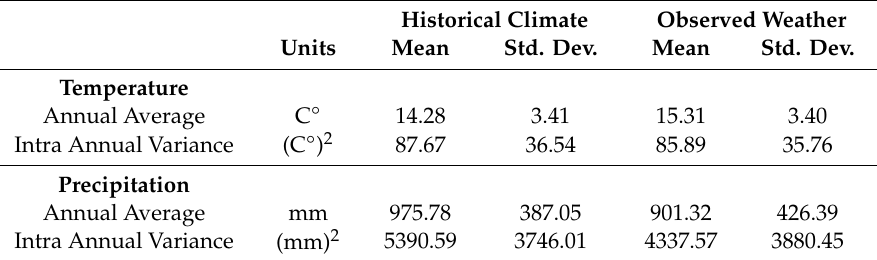
Table 3. Descriptive statistics of climate